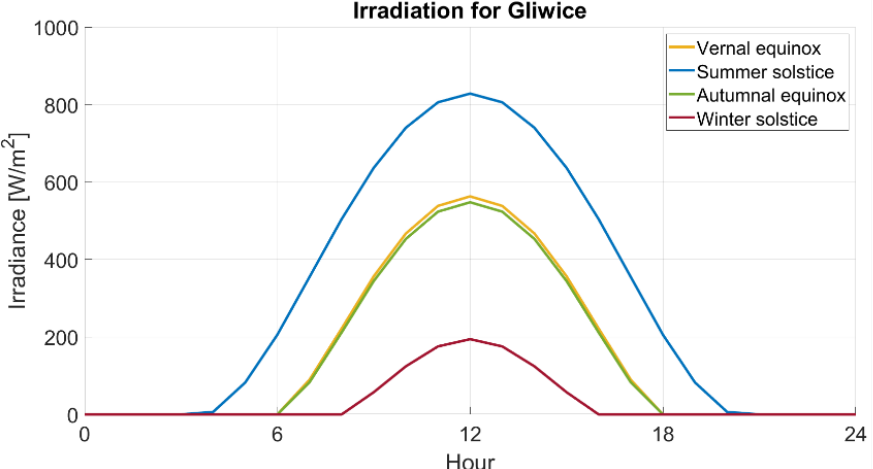
Figure 13. Irradiation for Gliwice for different days beginning seasons of the year.